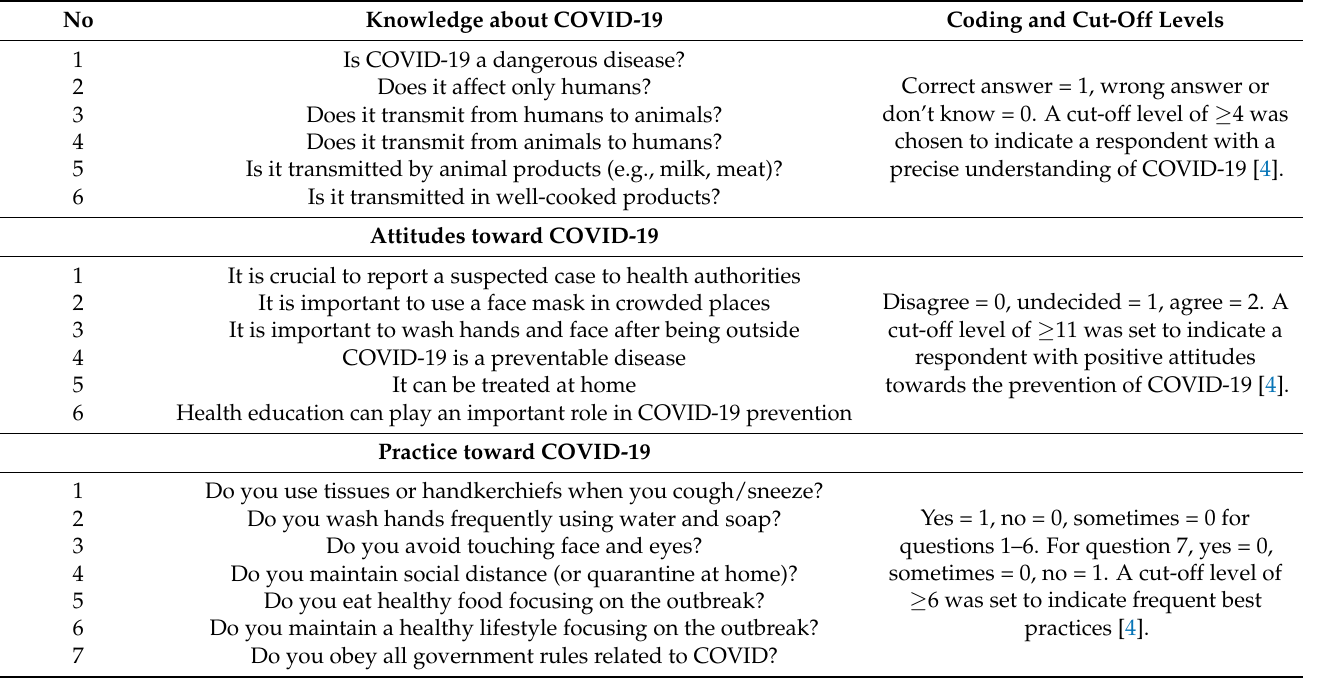
Table 1. Questionnaires on KAP regarding COVID-19